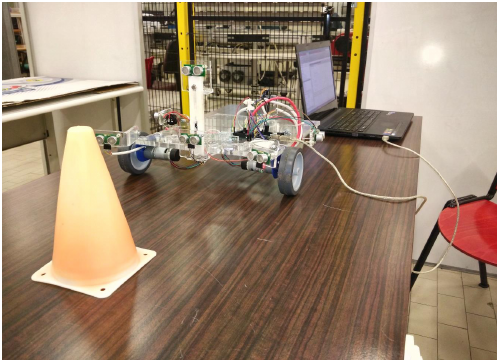
Figure 7. Data acquisition process for the cone geometry.